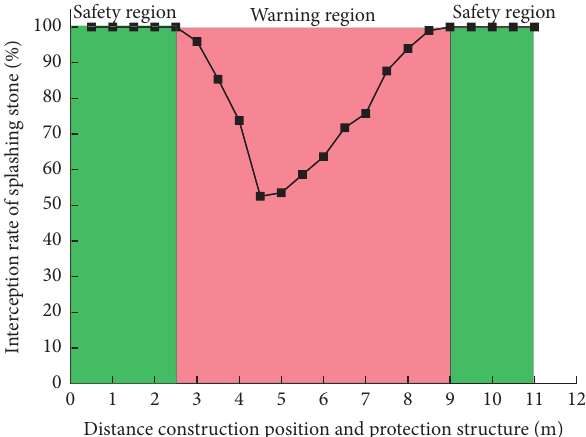
Figure 11: Relationship between initial movement point of splash stone and interception rate of protective